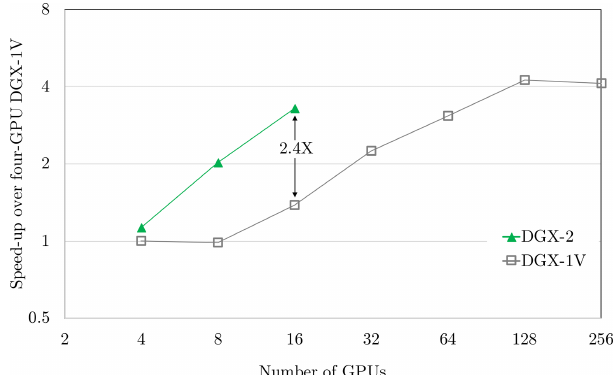
Figure 7. Computational performance of the spectral transform dwarf at 18km resolution ( N T = 639) on up to 16 GPUs on one DGX-2 and up to 32 DGX-1 servers connected with Infiniband. The DGX-1V uses MPI for ≥ eight GPUs (due to lack of all-to-all links); all others use CUDA IPC. DGX-2 results use preproduction hardware. The points were connected with lines for the purpose of improving